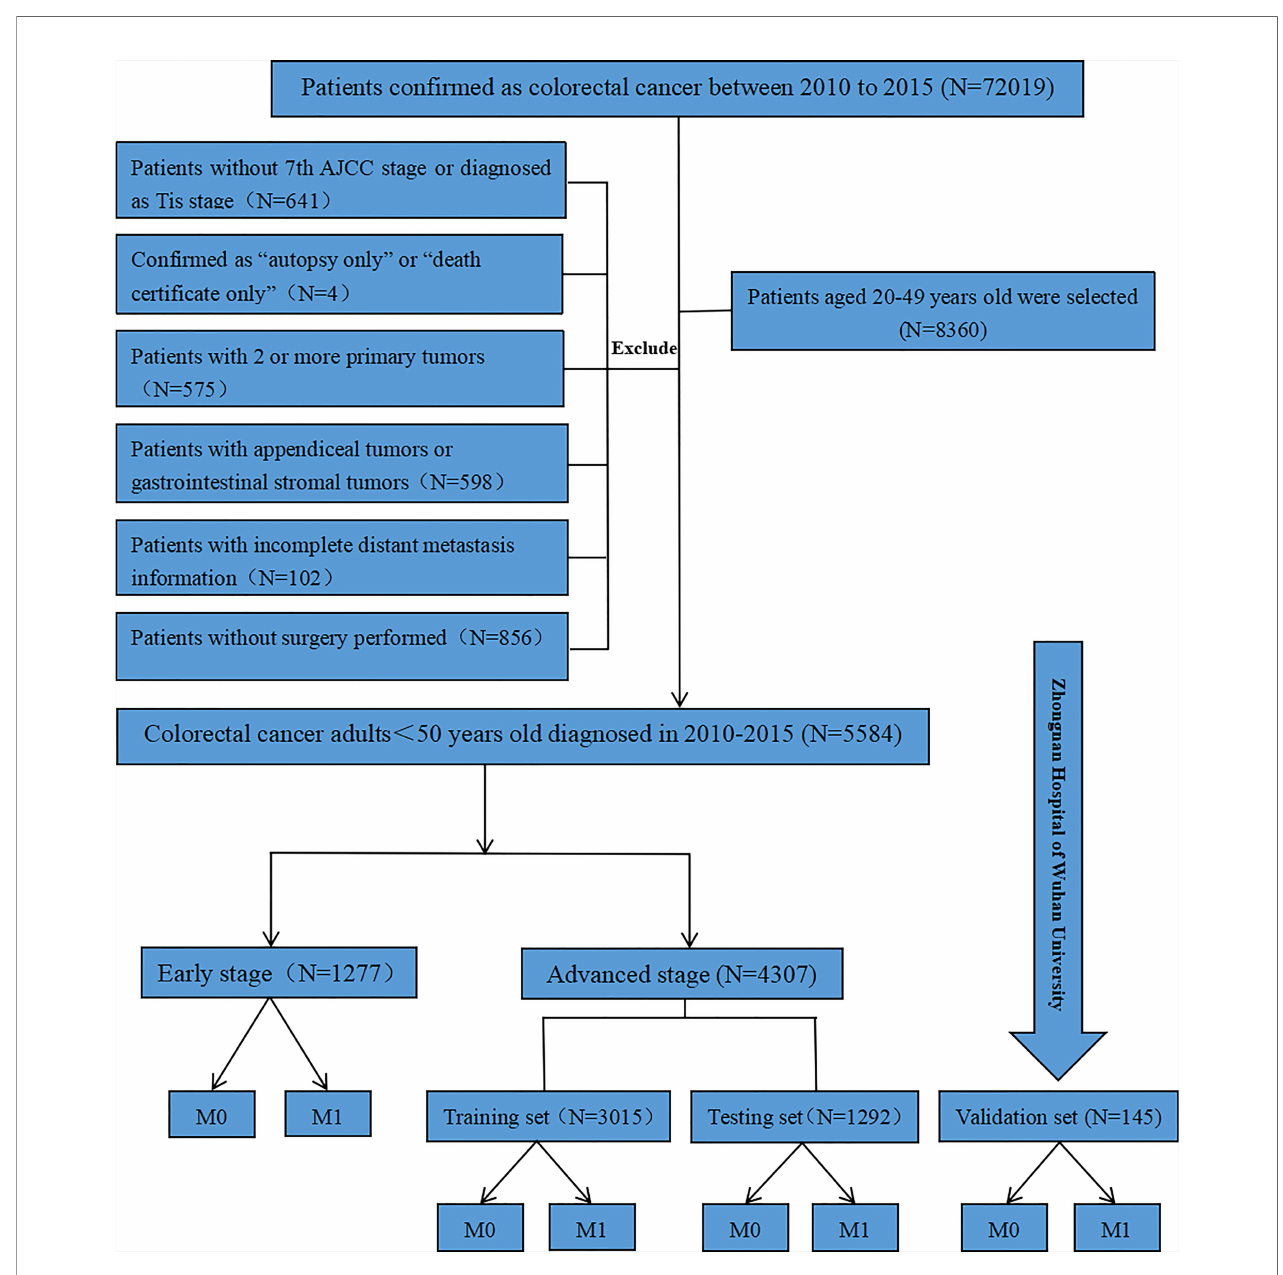
FIGURE 1 | Flow chart of participants inclusion. M1, distant metastasis; M0, no distant